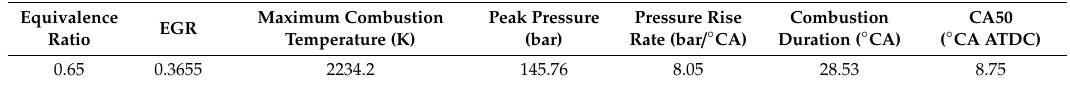
Figure 10. Optimizing process of genetic algorithm. Table 5. Optimized combustion control parameters. Table 5. Optimized combustion control parameters.